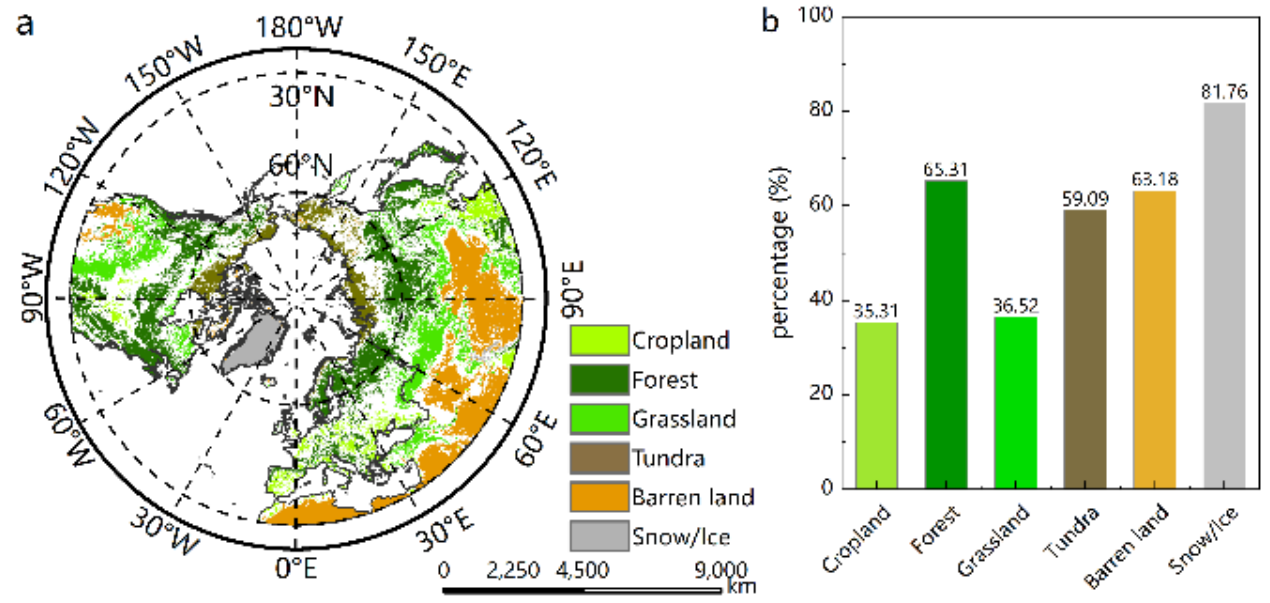
Figure 1. Spatial distribution and statistics of the study area. ( a ) Spatial distribution of stable (unchanged) land cover types in the period 1985–2015; changed regions are shown in white. ( b ) Percentage of stable land cover types in the period.